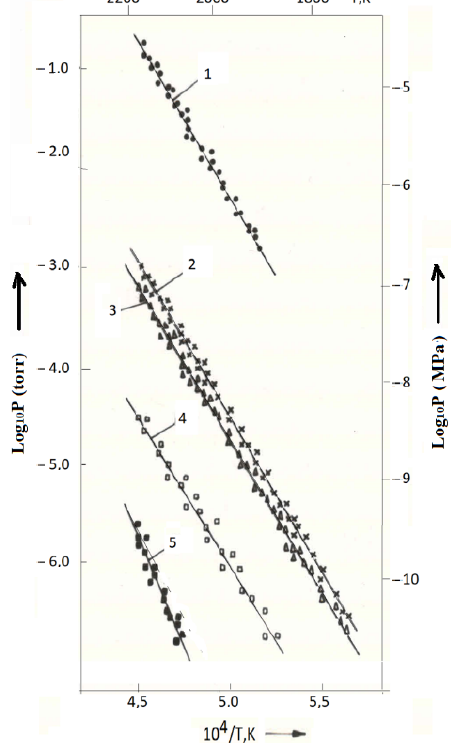
Figure 1. Dependence of partial pressures of gas phase components on temperature in Arrhenius coordinates over composition of sample 1 in Table 2 or No. 13 in Table 5: 1—nitrogen, 2—total pres- sure U + UO, 3—uranium monoxide, 4—uranium, 5—uranium from uranium nitride, 6—uranium mononitride, 7—uranium dioxide.